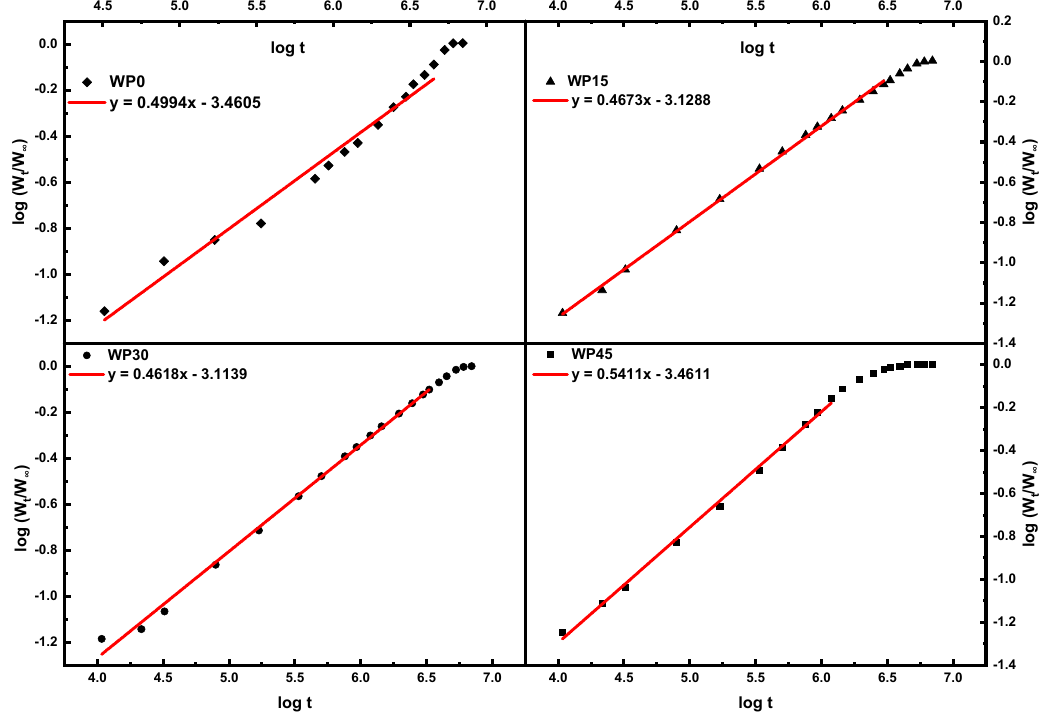
Figure 3. Diffusion case fitting plots for wood-filled polypropylene composites at 60 °C.